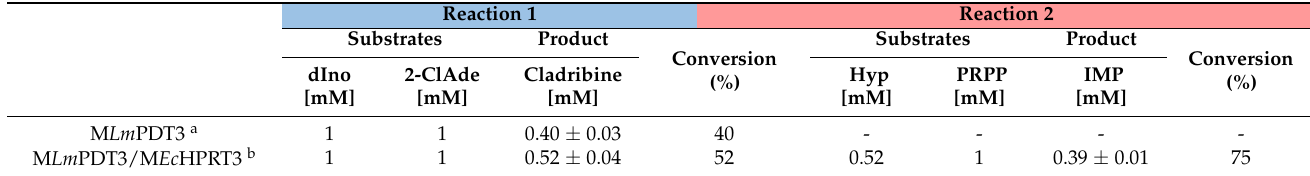
Table 1. Enzymatic synthesis of cladribine M Lm PDT3 or M Lm PDT3/M Ec HPRT.